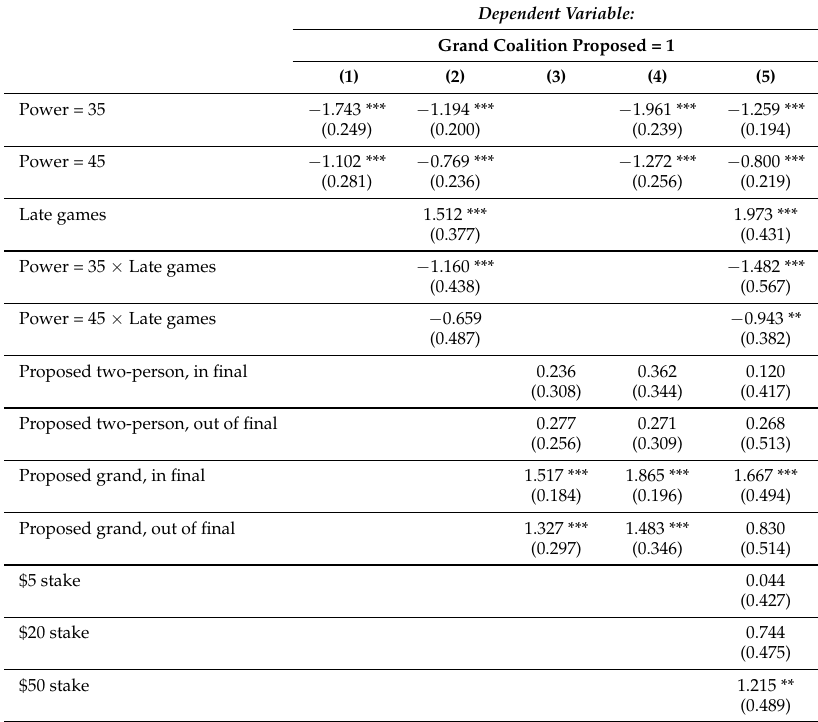
Table A4. Probability of proposing the grand